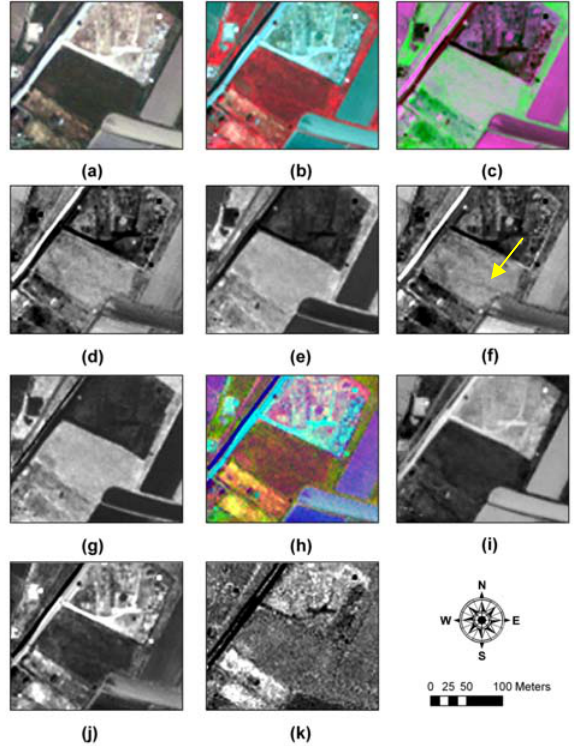
Figure 7. Results from QuickBird dataset from the western part of Elis archaeological site (37°53'17.46"N, 21°22'25.29"E). (a) RGB composite; (b) NIR-R-G composite; (c) Proposed linear transformation RGB pseudo colour; (d) first component; (e) second component; (f) third component; (g) NDVI; (h) PCA composite; (i) first PCA component; (j) second PCA component and (k) third PCA component.